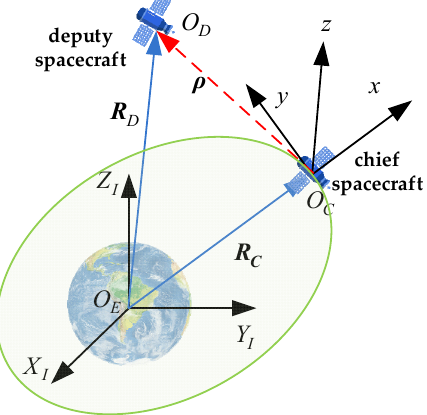
Figure 1. Definition of coordinate frames.